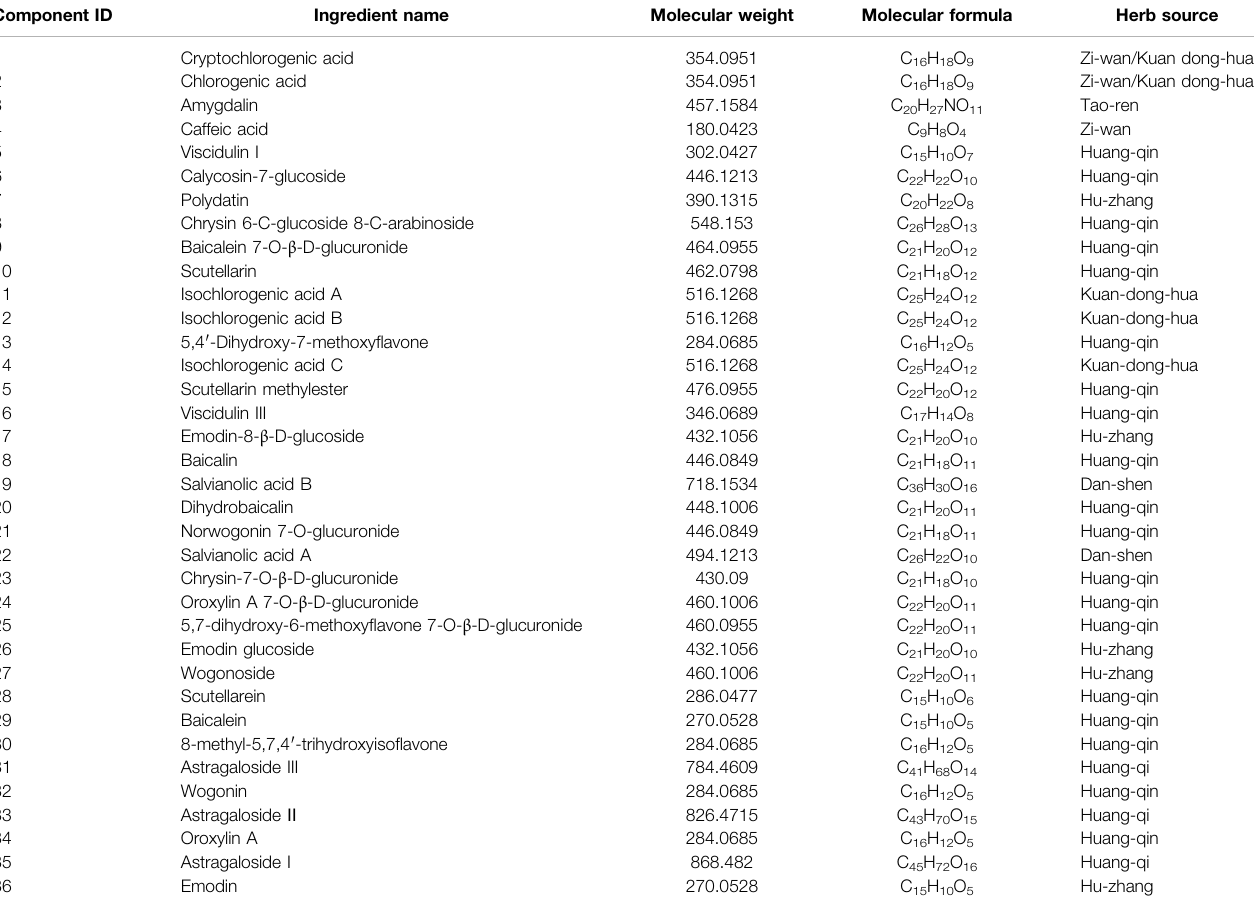
TABLE 2 | The 36 components of WBT formula from UHPLC/Q-TOF-MS analysis screened according to PubChem database. Component